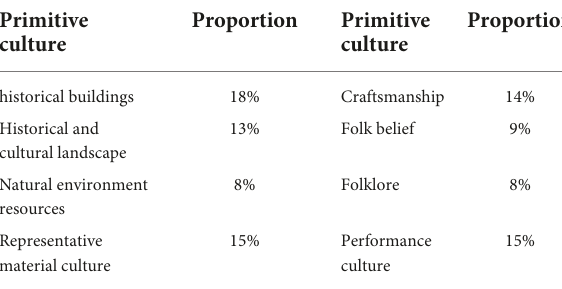
TABLE 5 Preferences and